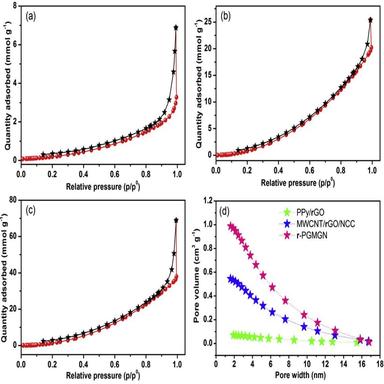
Nitrogen adsorption-desorption isotherms of (a) PPy/rGO, (b) MWCNT/rGO/NCC, and (c) r-PGMGN and (d) pore distributions of PPy/rGO, MWCNT/rGO/ NCC, and r-PGMGN.